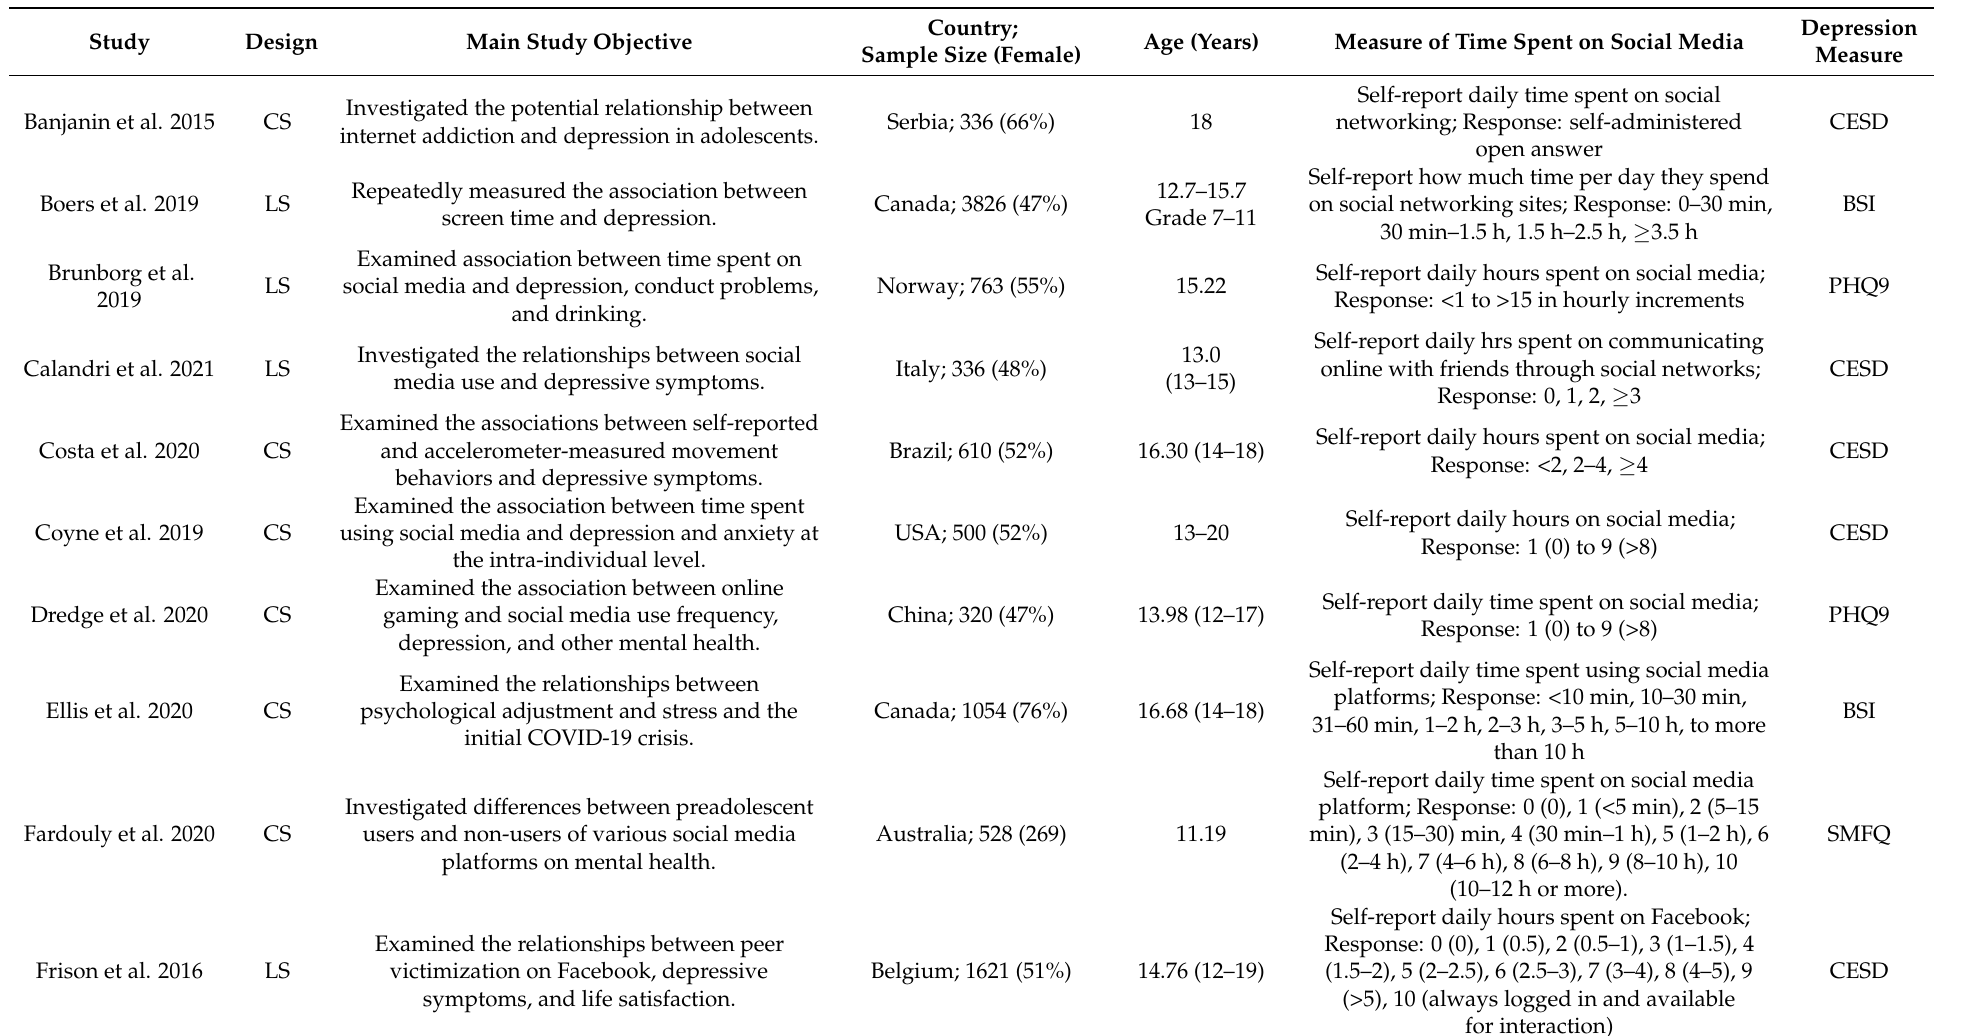
Table 1. The Characteristics of the included